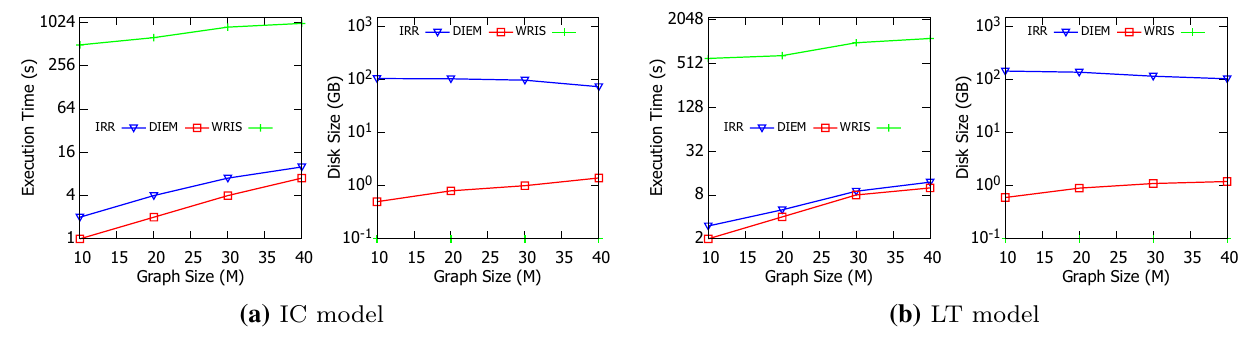
Fig. 2 Varying the graph size: | V |